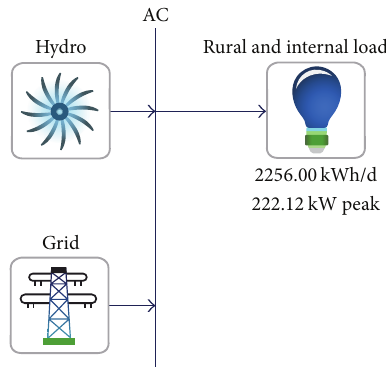
Figure 7: HOMER system